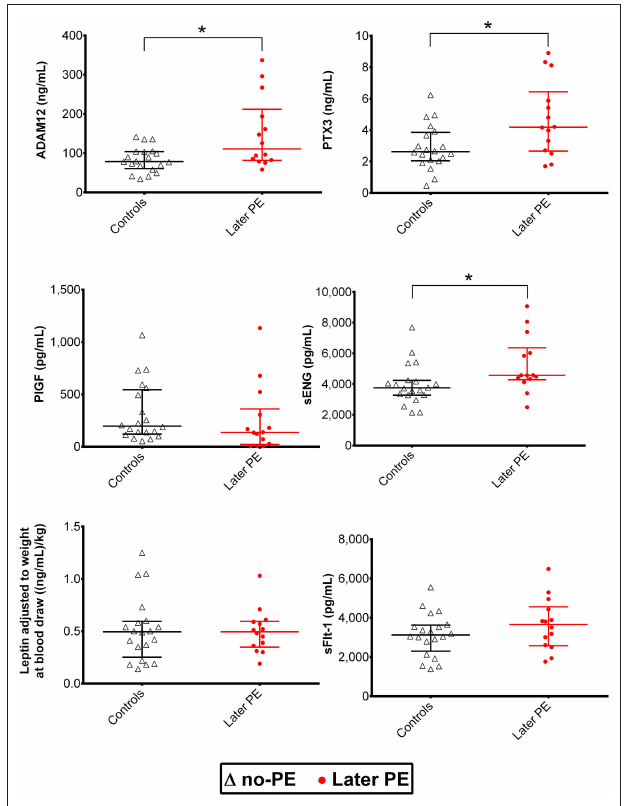
FIGURE 2 | Distribution of maternal serum biomarkers measured with the Luminex ® 6PLEX assay during early pregnancy, stratified by the later onset of preeclampsia (PE). Samples from women that later developed PE ( n = 14, drawn at 70–98 gestational days) were compared to samples representing uncomplicated gestations until term ( n = 20, 76–96 gestational days; Table 1 ). The whiskers on the plot show the median with an interquartile range. The statistical difference in biomarker distributions between PE and control cases was compared using the Mann-Whitney U-test, * representing P < 0.05. ADAM12, disintegrin and metalloproteinase domain-containing protein 12; PlGF, placental growth factor; PTX3, pentraxin-3; sENG, soluble endoglin; sFlt-1, soluble fms-like tyrosine kinase-1.